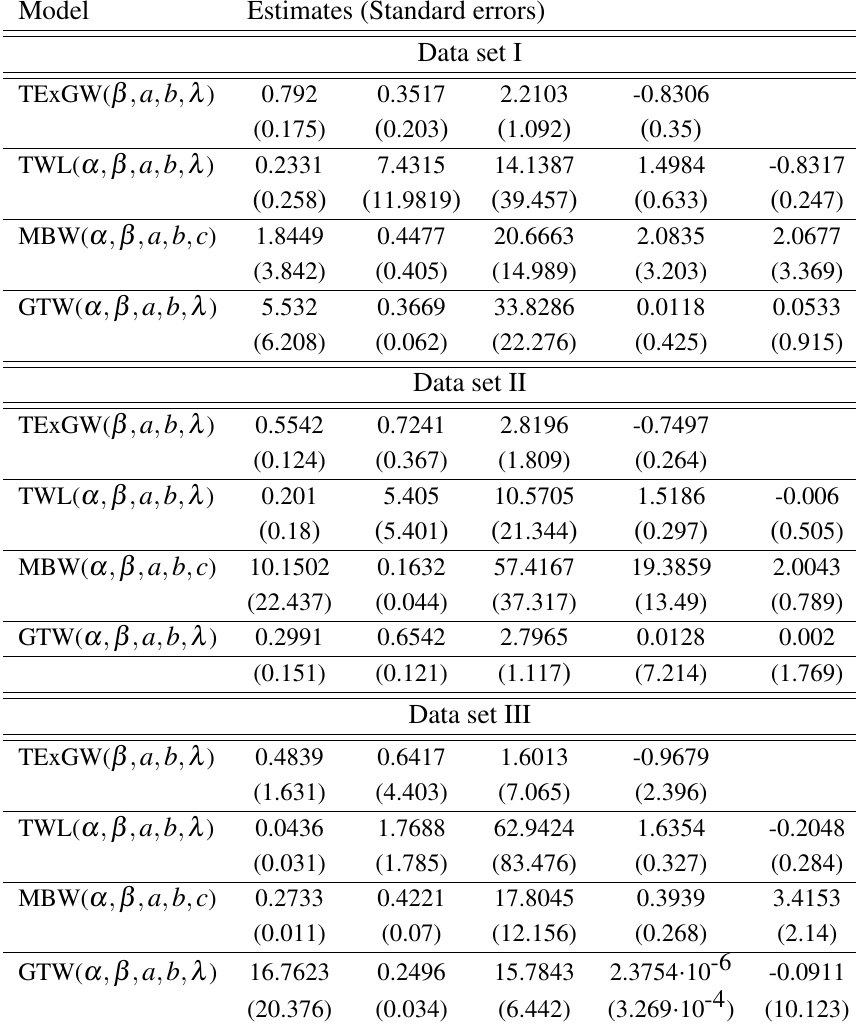
Table 4. MLEs and their standard errors for the data sets I, II and